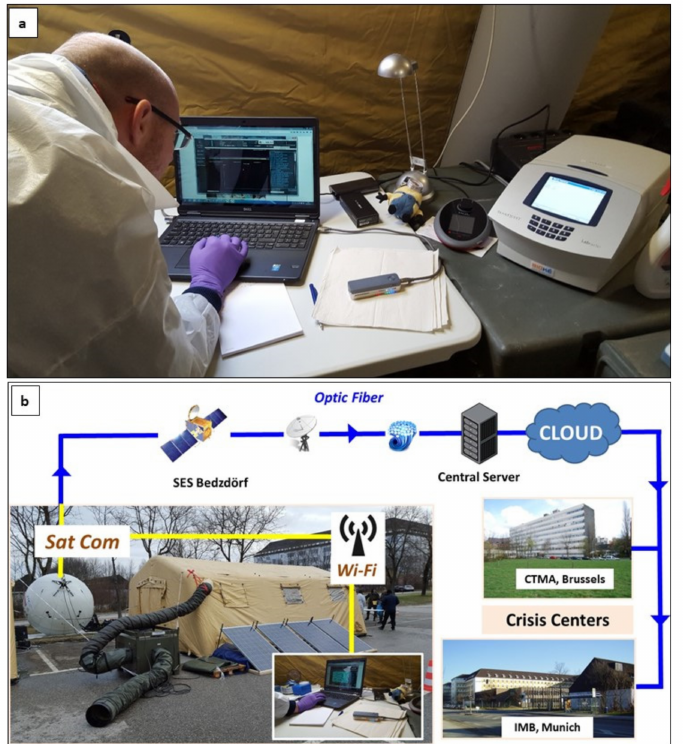
Figure 4. Exercise “Clueless Snowman” in the Institute of Microbiology, Bundeswehr, Munich: ( a ) Use of the MinION sequencer (ONT) in the B-LiFE facility during the exercise “Clueless Snowman”; ( b ) MinION data flow from the laboratory to the tent to the crisis